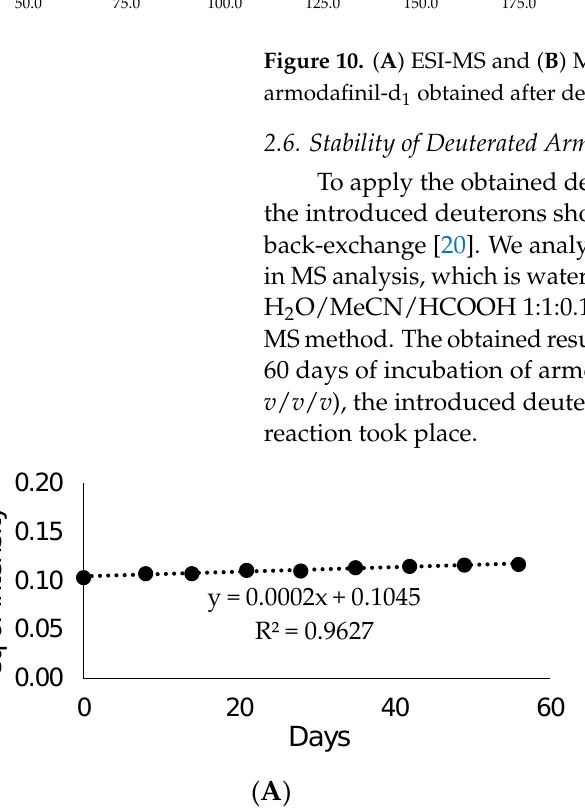
Figure 10. ( A ) ESI-MS and ( B ) MS/MS (parent ion 297.075 m/z , collision energy 30 eV) spectra of armodafinil-d 1 obtained after deuterium–hydrogen exchange.